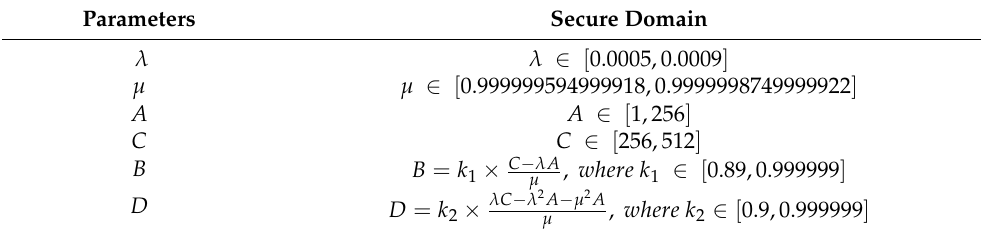
Table 1. Secure domains of the control